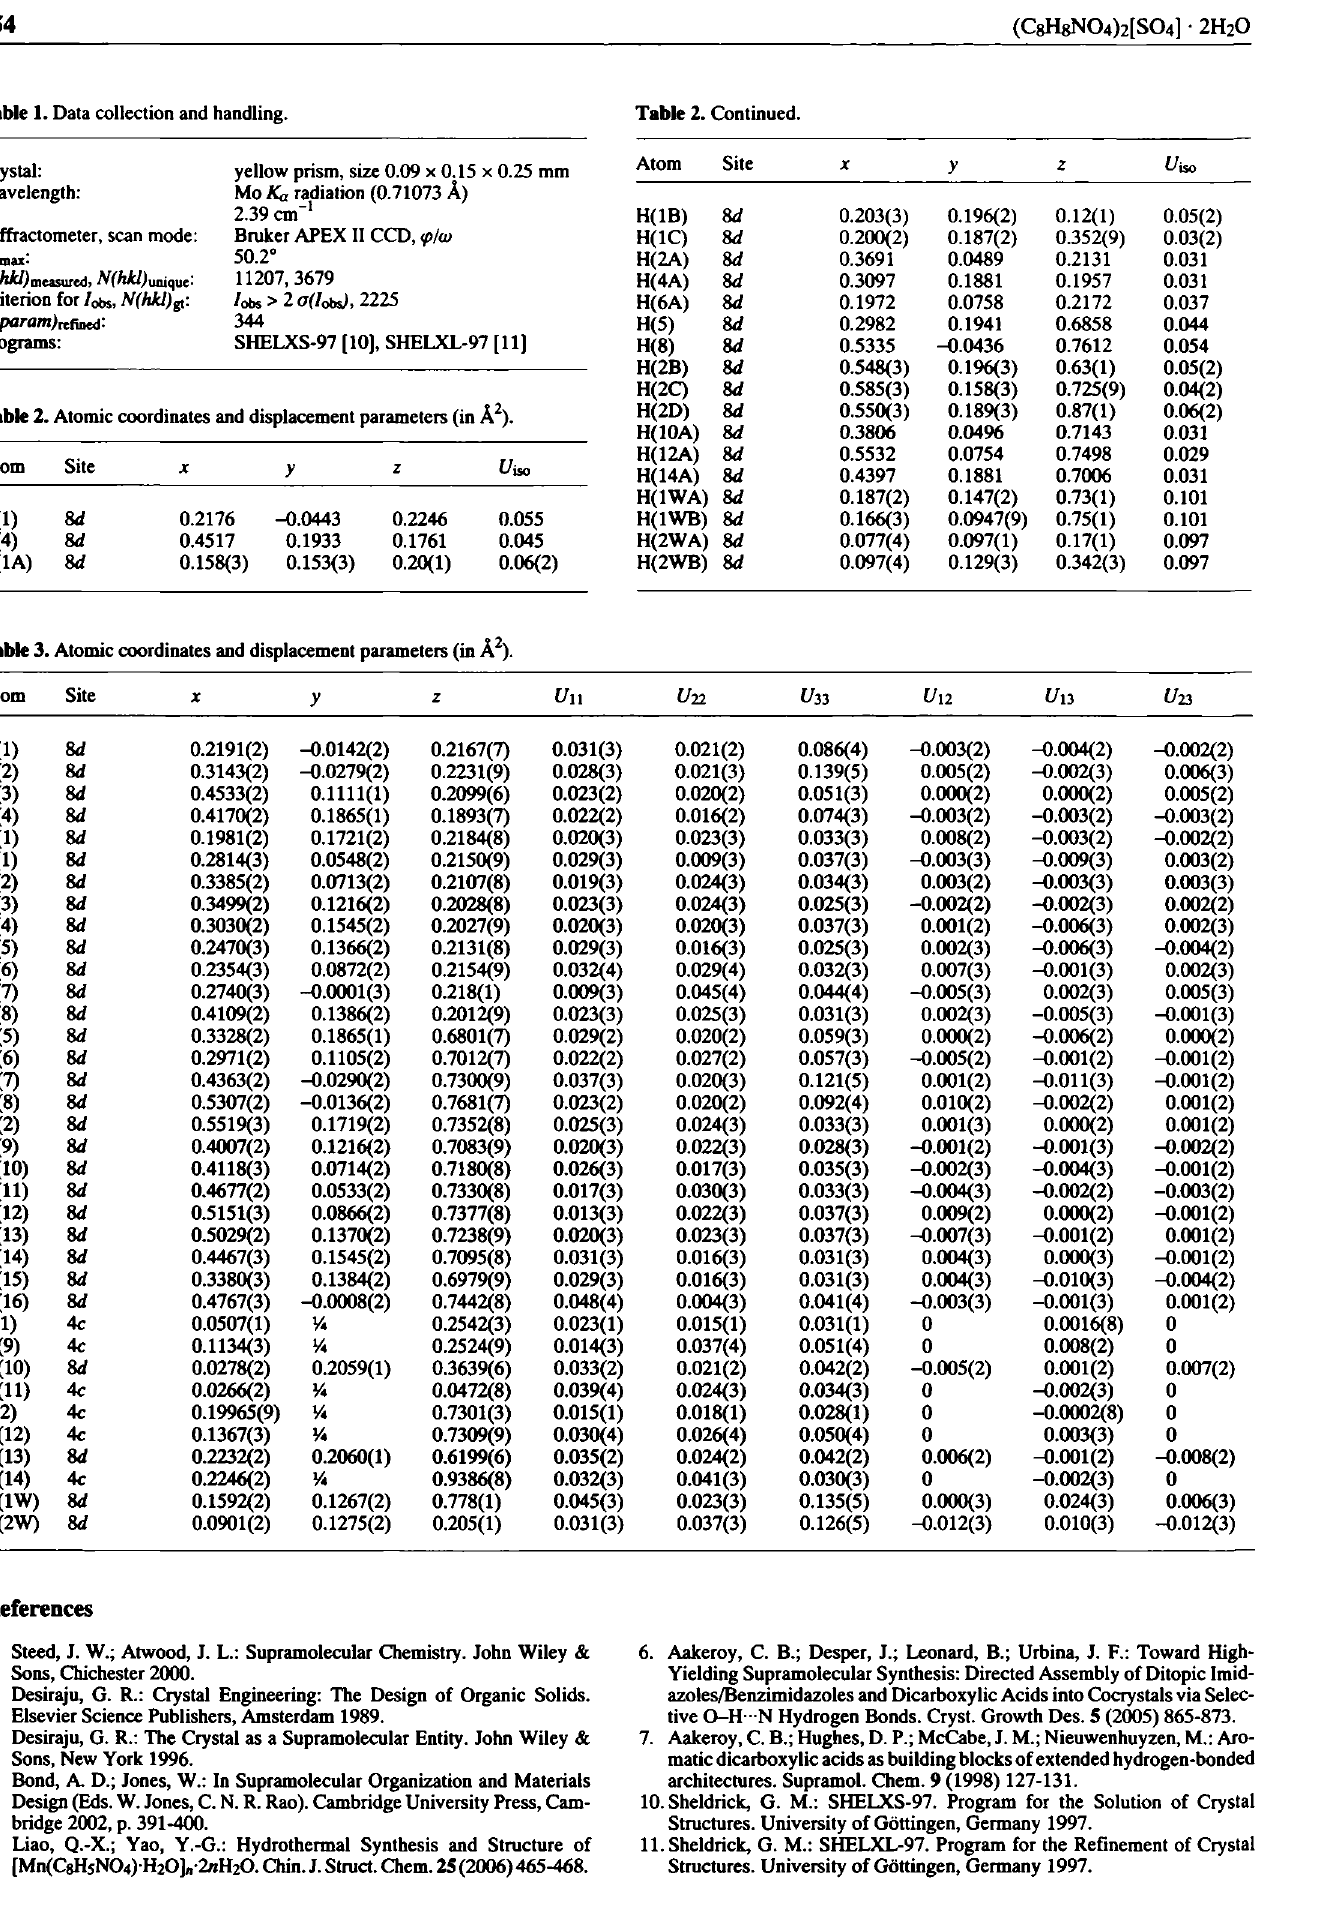
Table 3. Atomic coordinates and displacement parameters (in Ä 2